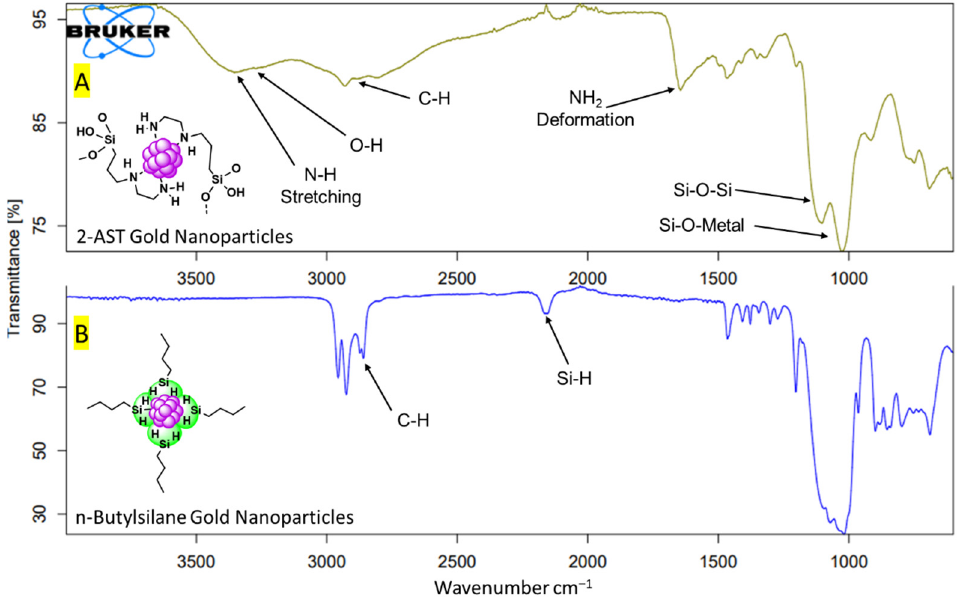
Figure 4. Infrared Spectrum Analysis of ( A ) n-butylsilane vs. ( B ) dried Au nanoparticles after phase transfer with n-butylsilane.